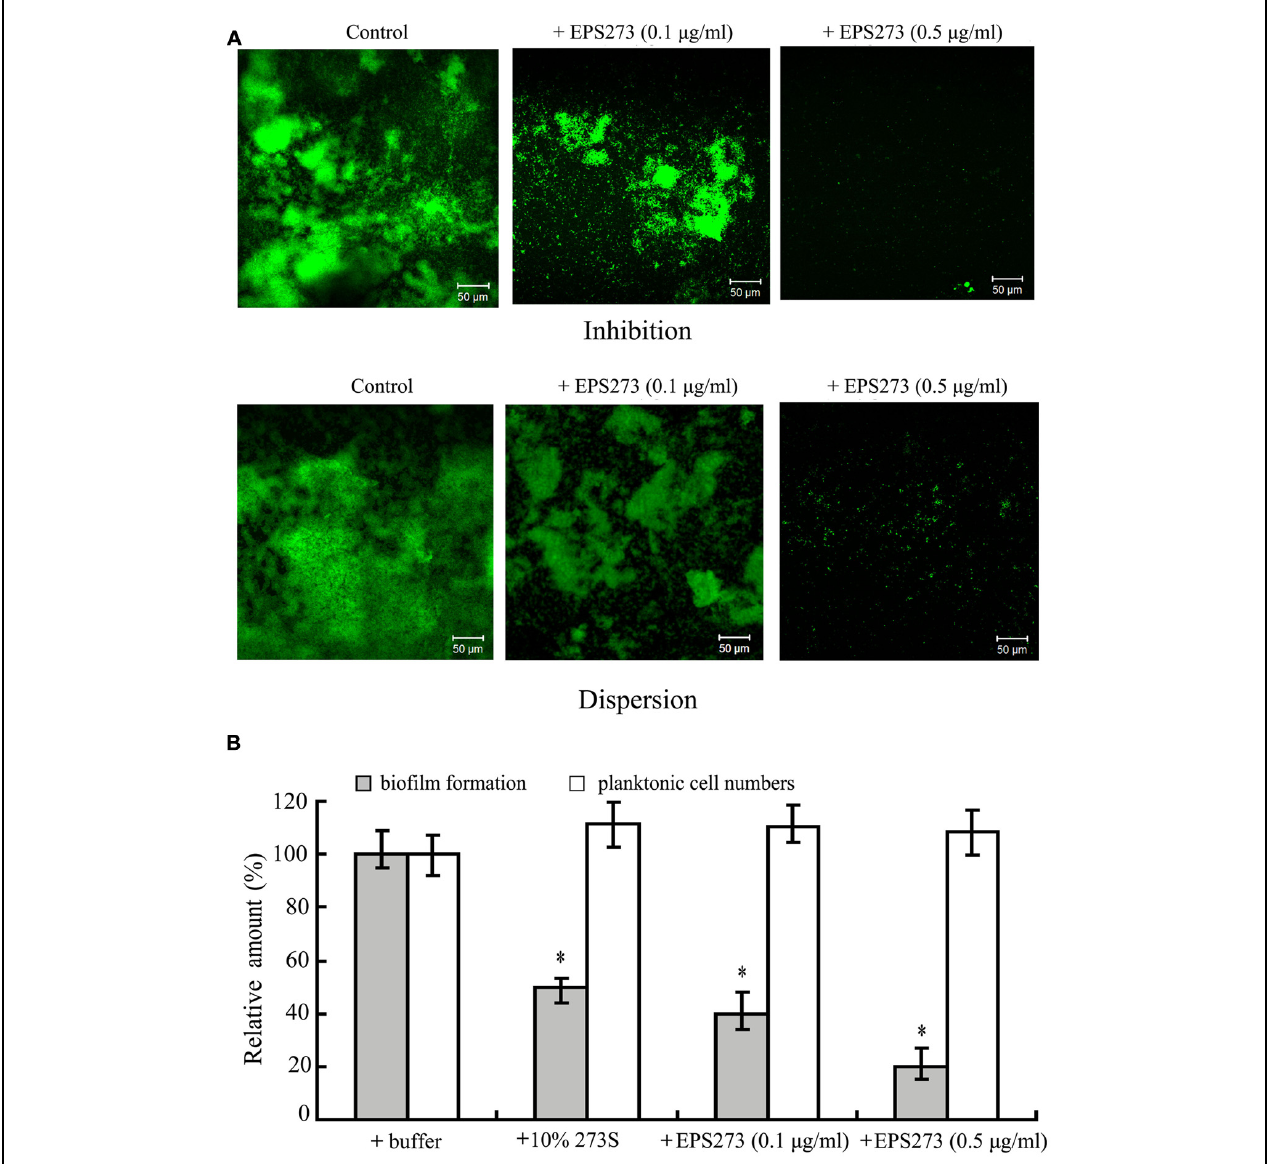
FIGURE 4 | Anbibiofilm and antibacterial activity analyses of purified EPS273. (A) Florescence microscopic observation of inhibition on biofilm formation and dispersion on preformed biofilm by EPS273. The images are representative of three separate experiments. (B) Antibacterial activity analyses of EPS273. Error bars indicate the standard deviations of three measurements. ∗ P < 0.05 versus the